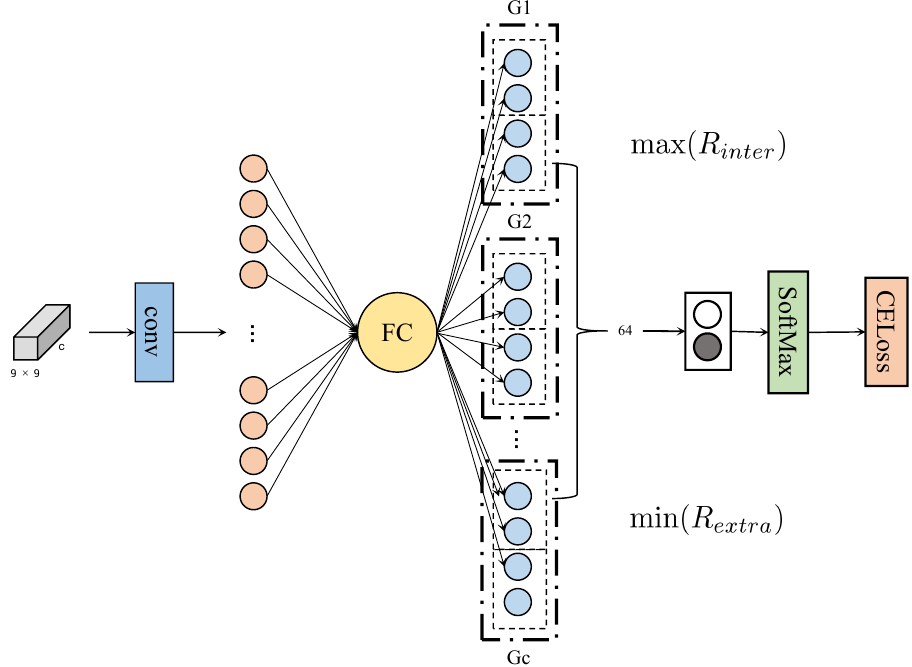
Figure 5. Structure of the proposed feature redistribution loss function using the maximized inter- group relation and minimized extra-group relation. Hidden features are divided into c